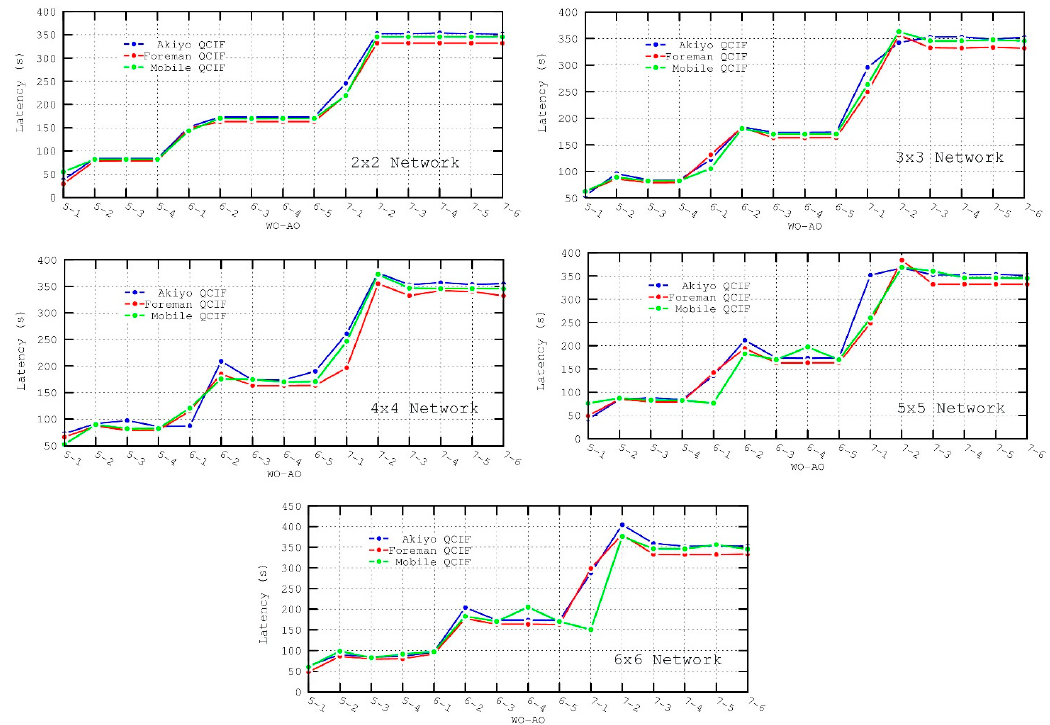
Figure 8. Latency metric for the different scenarios.